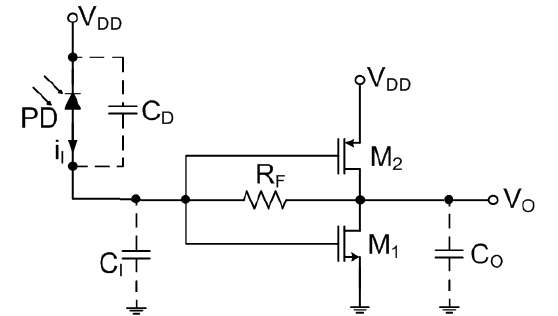
Figure 3. Push-pull inverter TIA with resistive feedback.